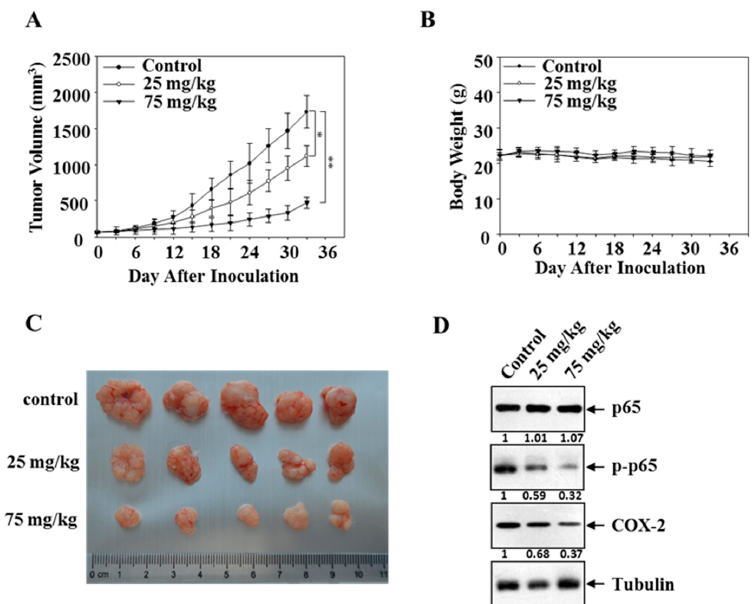
Figure 6. Effect of mollugin on human xenograft model. ( A , B ) HeLa cells were implanted s.c. in the left flanks of nude mice, which were administered by gavage three times a week with vehicle ( n = 5), mollugin (25 mg/kg, n = 5) or mollugin (75 mg/kg, n = 5) starting from day ten. Tumor volume and mouse weight were measured using calipers and a disital balance, respectively, every three days; ( C ) representative tumor masses of three groups, which were harvested 4 h after the last treatment (and the isolated tumors were photographed); ( D ) western blot analysis of p-p65 and COX-2 in tumor blocks is shown. Tubulin was used as a loading control.